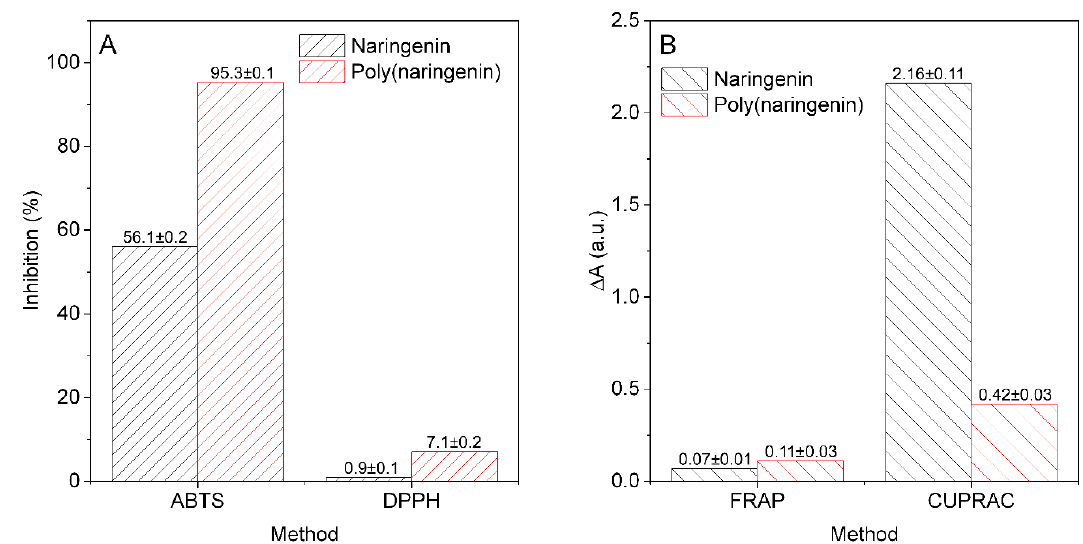
Figure 9. Ability of 1 mg/mL naringenin and poly(naringenin) to reduce radicals ABTS and DPPH ( A ) and for reduction of Fe 3+ and Cu 2+ ions measured by FRAP and CUPRAC tests ( B ).